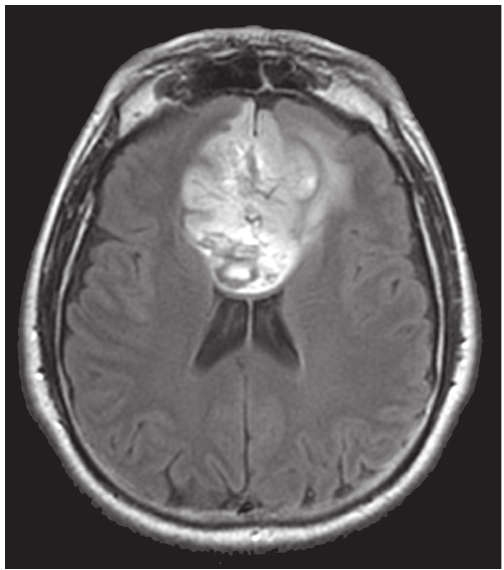
Figure 1: Axial FLAIR MR shows a large inhomogeneously hyper- intense, extraaxial mass, located in the frontobasal region. The lesion compresses and displaces both the frontal horns of lateral ventricles and the corpus